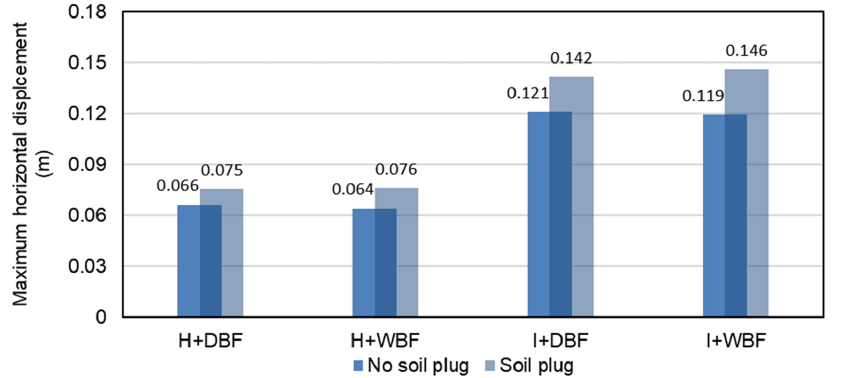
Figure 8. The maximum horizontal displacement of bucket foundations in 50% relative density liquefiable seabeds.